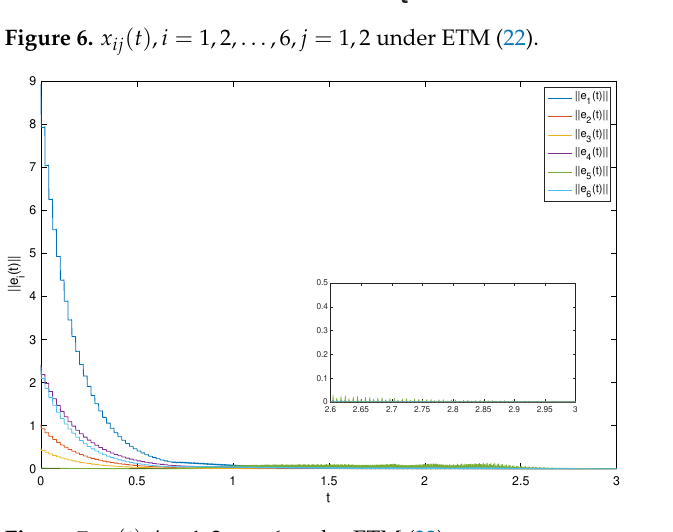
Figure 7. e i ( t ) , i = 1,2, . . . ,6 under ETM (22). The event-triggered impulsive series are given in Figure